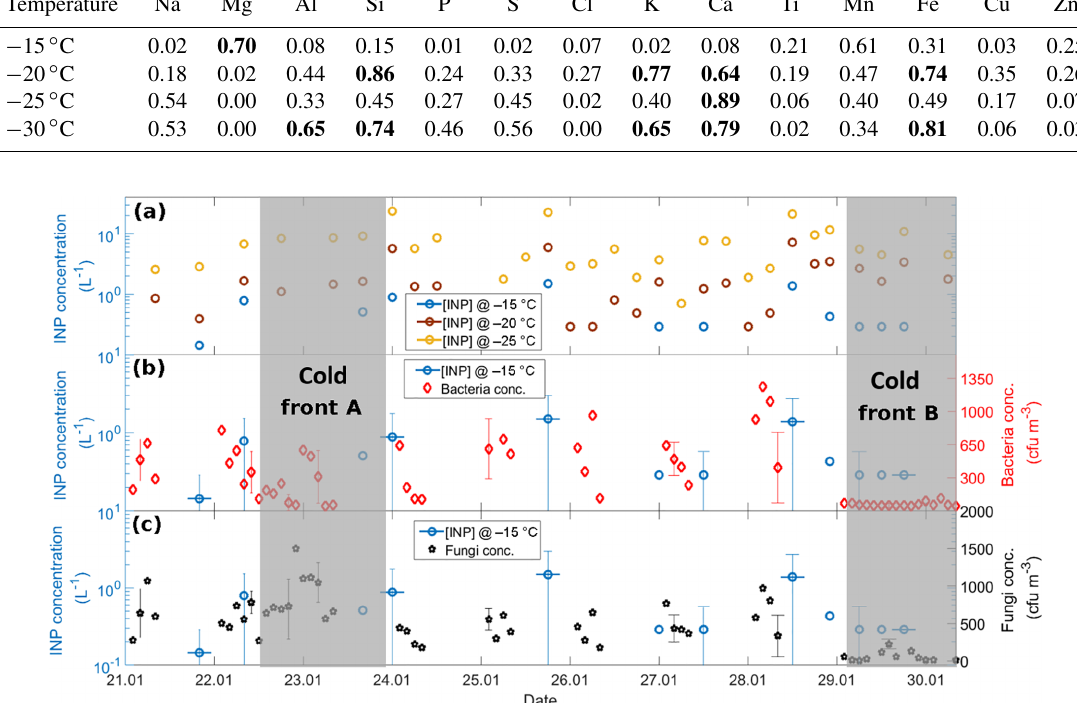
Figure 9. (a) Time series of the [INP] at − 15 (blue), − 20 (brown), and − 25 ◦ C (yellow), (b) time series of the [INP] at − 15 ◦ C (blue) together with bacteria concentration (red), and (c) time series of the [INP] at − 15 ◦ C (blue) together with fungal concentration (black). Each x -axis tick corresponds to 06:00 local time. The horizontal uncertainty bars indicate the time span of the MOUDI-DFT measurements, i.e., 6h. Grey areas denote the periods affected by cold fronts A and